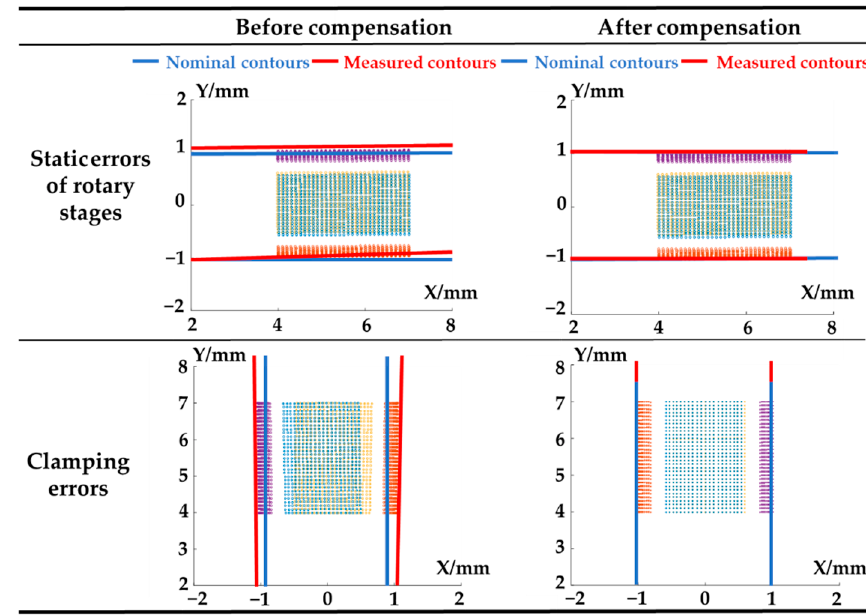
Figure 9. Results of the error compensation in the simulation.